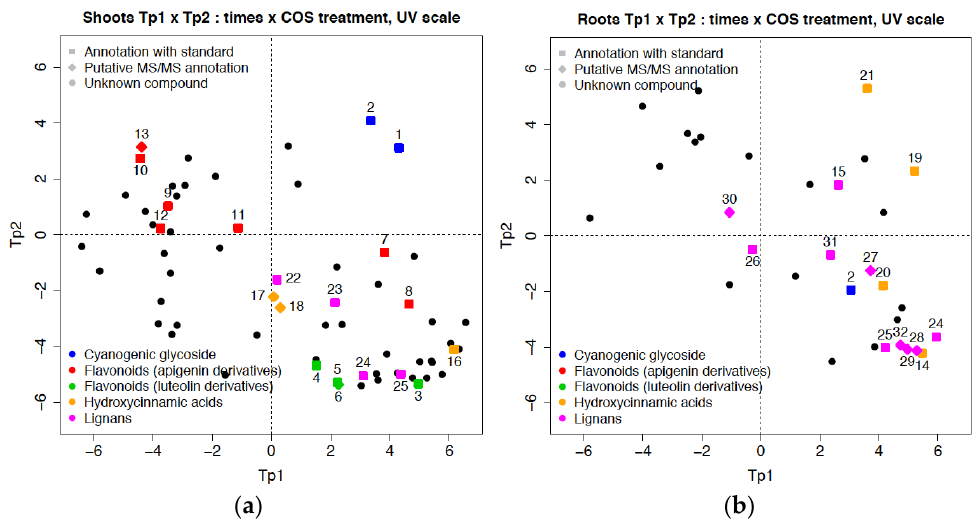
Figure 6. Loading plot of: ( a ) shoot metabolites; and ( b ) root metabolites of flax seedlings from the control and treated with COS solution.